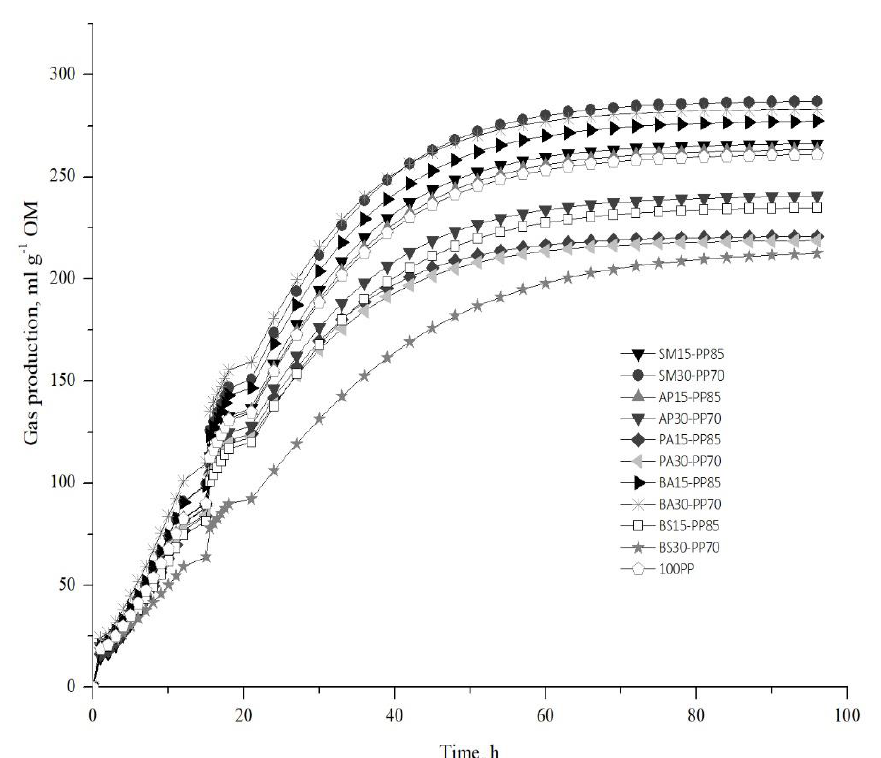
Figure 2. Gas production in mL g − 1 organic matter per hour. Abbreviations: SM15-PP85 (15% S.